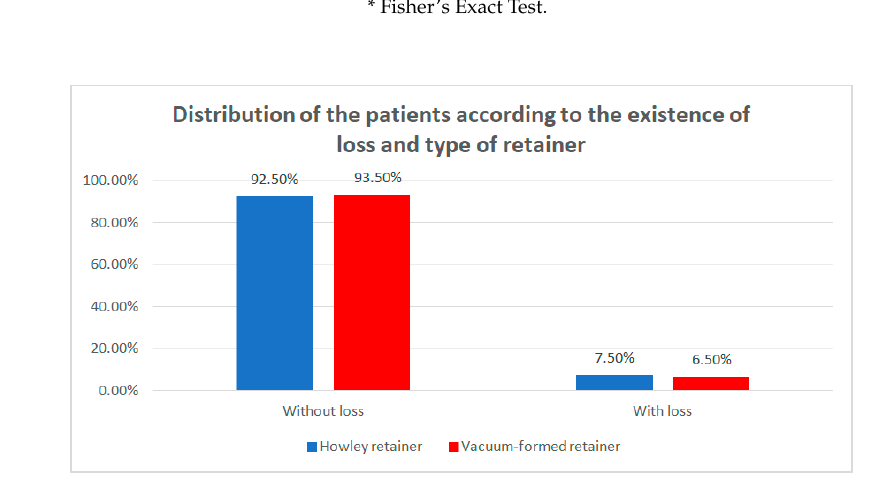
Figure 7. Distribution of the patients according to the existence of loss and type of retainer.